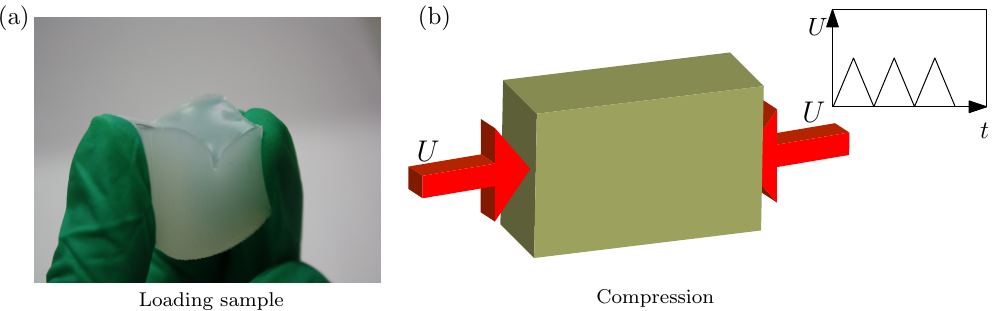
Figure 2. ( a ) cyclic pinching on a cuboid silicone rubber; ( b ) schematic of the cyclic pinching. The loading-unloading is controlled by the imposed